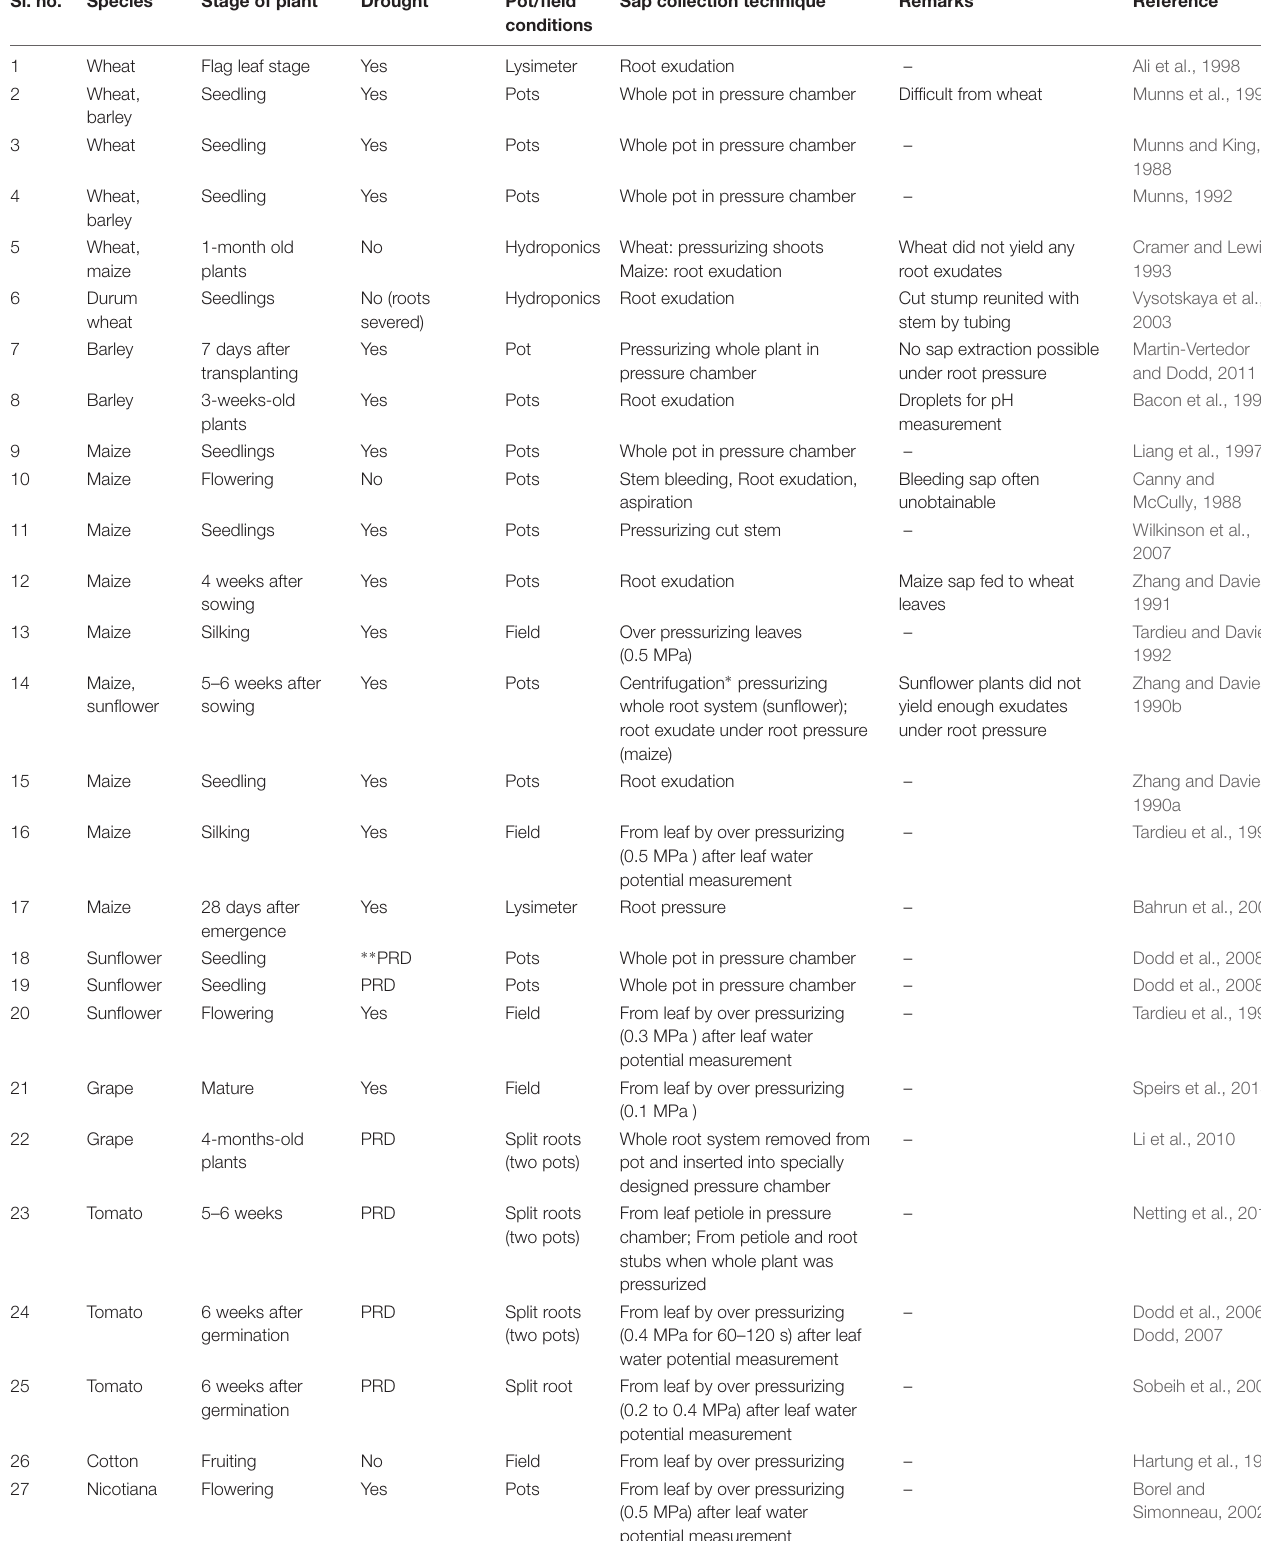
TABLE 2 | Summary of the literature showing methodology used to collect xylem sap from different species. Sl. no.